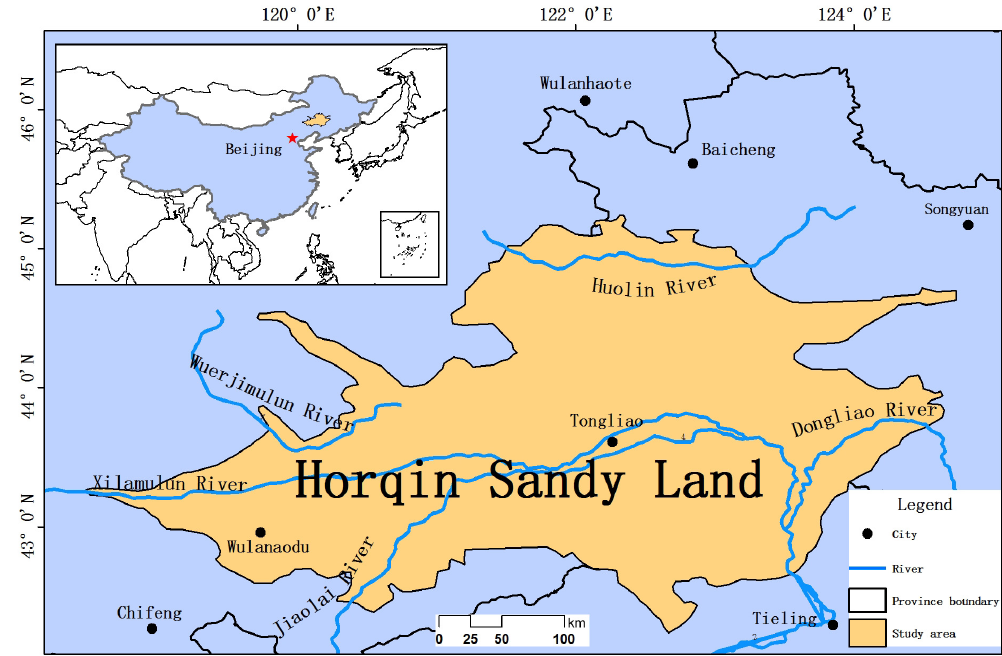
Figure 1. The geographic location of study area in the Horqin Sandy Land,